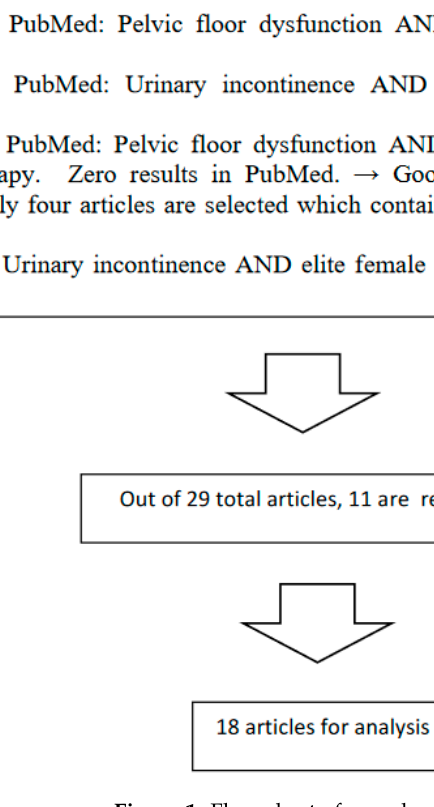
Figure 1. Flow chart of sample selection.